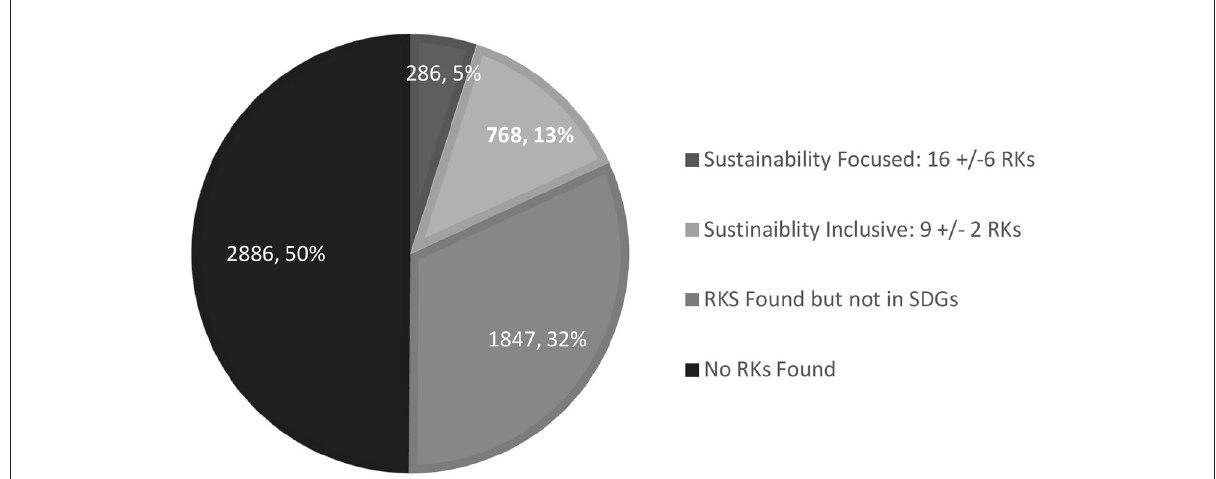
FIGURE7 Statistical categorization of TU Dublin modules based on AASHE-STARS criteria (number and % of modules